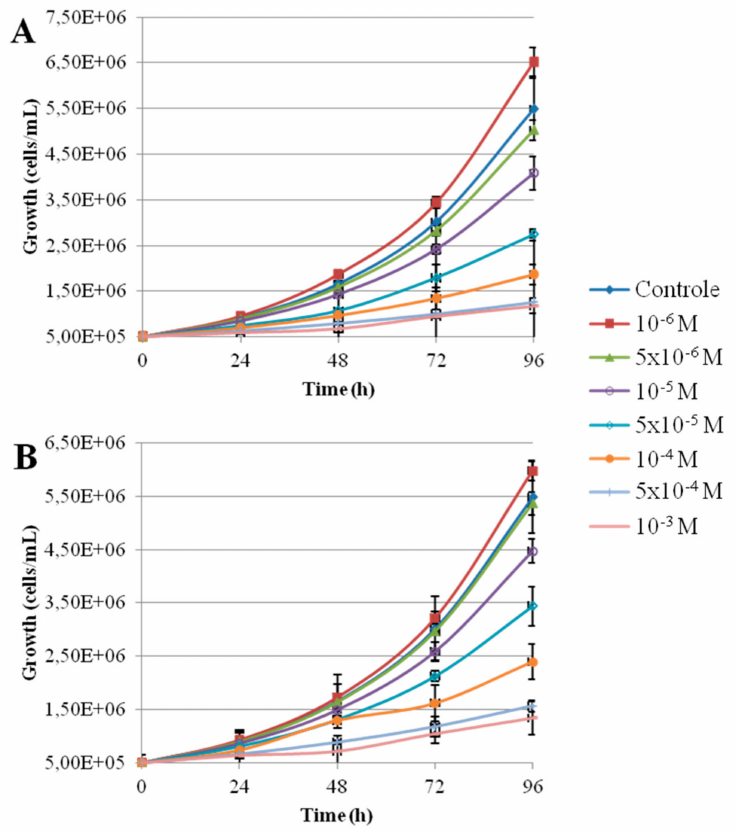
Figure 2. Growth rate of Chlorella vulgaris as a function of time after contact with Zn 2 + free ions and ZnO nanoparticles in Seine river water: ( A ) Zn 2 + , ( B )